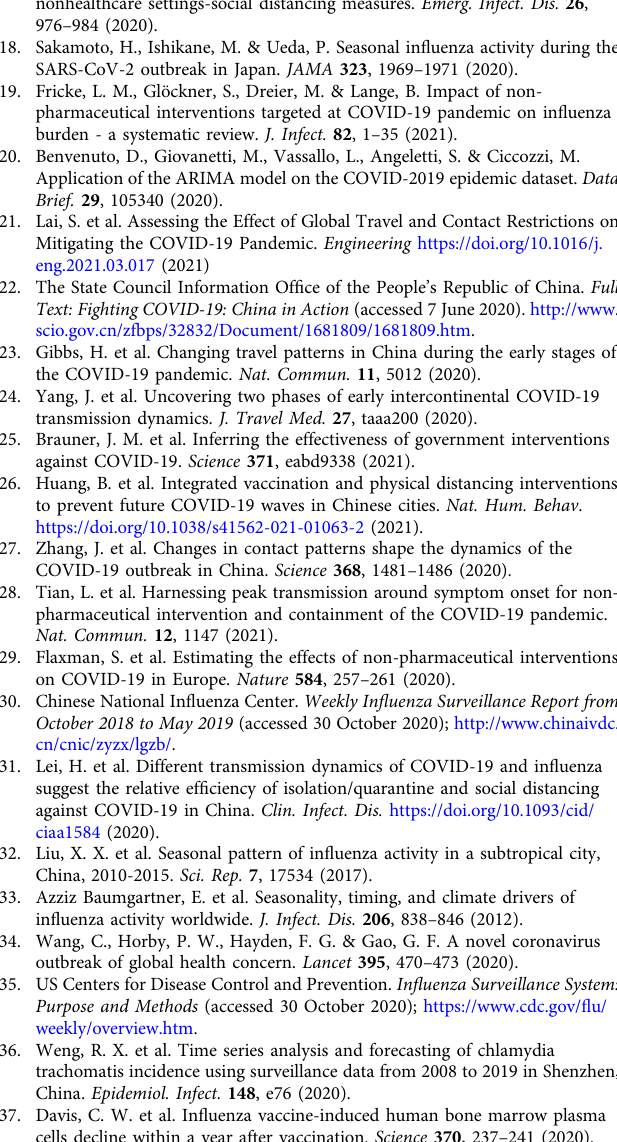
(Table 1), according to the timings of the fi rst identi fi cation of SARS-CoV-2 and the implementation of strict NPIs in China, and the dates of the fi rst COVID-19 con fi rmed case reported and the national emergency declared in the US. Descriptive statistics and time-series analyses were conducted using SAS JMP Pro 14 and SPSS 22.0. The 2019 – 2020 curve area difference for assessing the NPIs effectiveness used Graphpad prism 8.0. R version 3.6.1 (R Foundation and Origin 2019 for Statistical Computing, Vienna, Austria) was used to plot fi